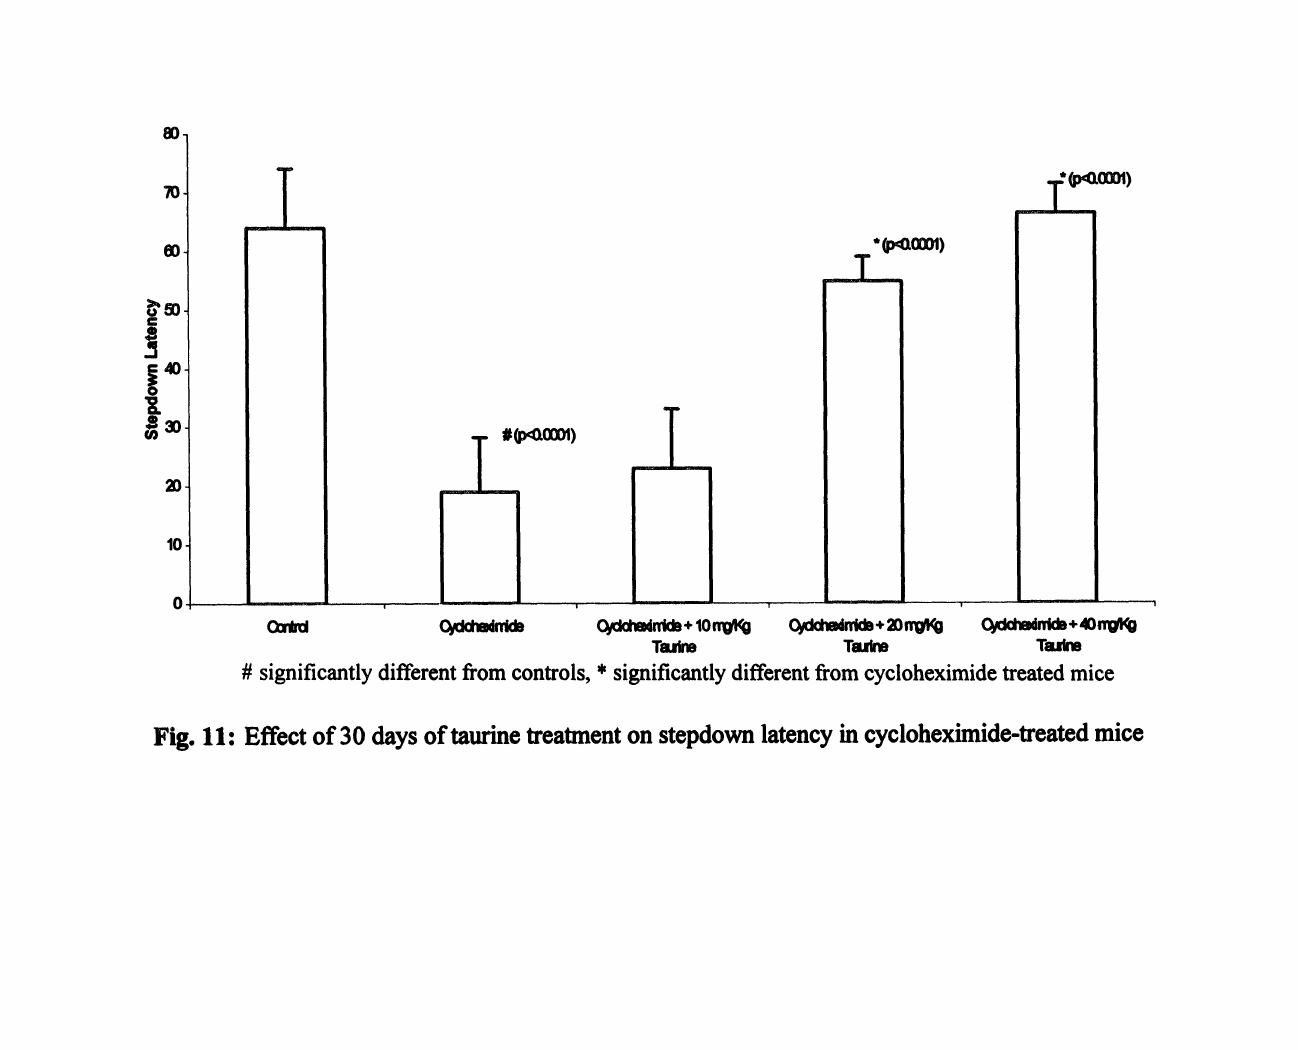
Fig. 10: Effect of 10 days oftaurine treatment on escape latency in cycloheximide-treated mice